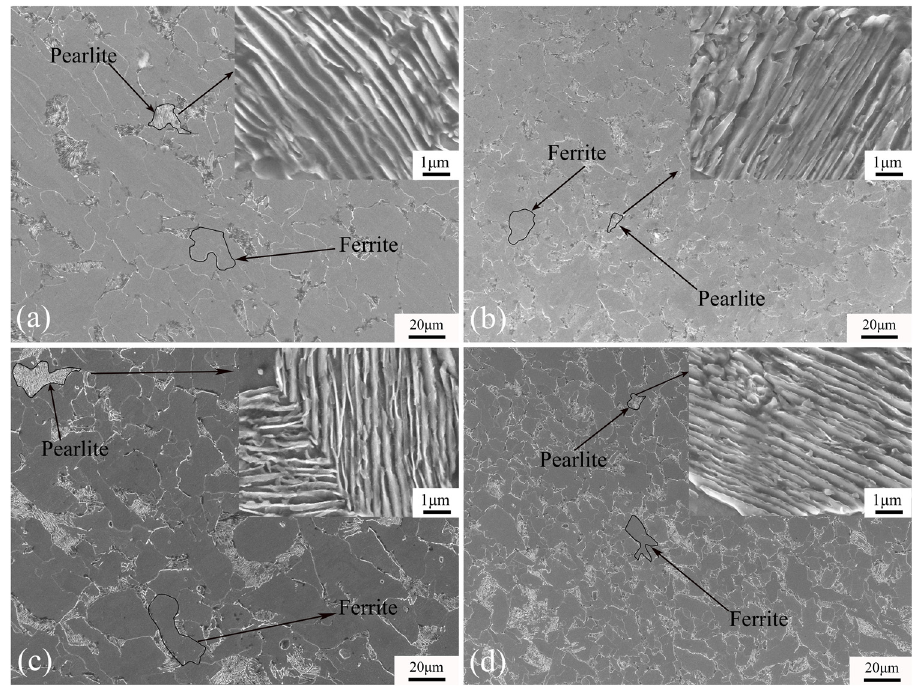
Figure 3: SEM morphology under the conditions of di ff erent isothermal times: ( a ) 30 s, ( b ) 60 s, ( c ) 100 s, and ( d ) 200 s.